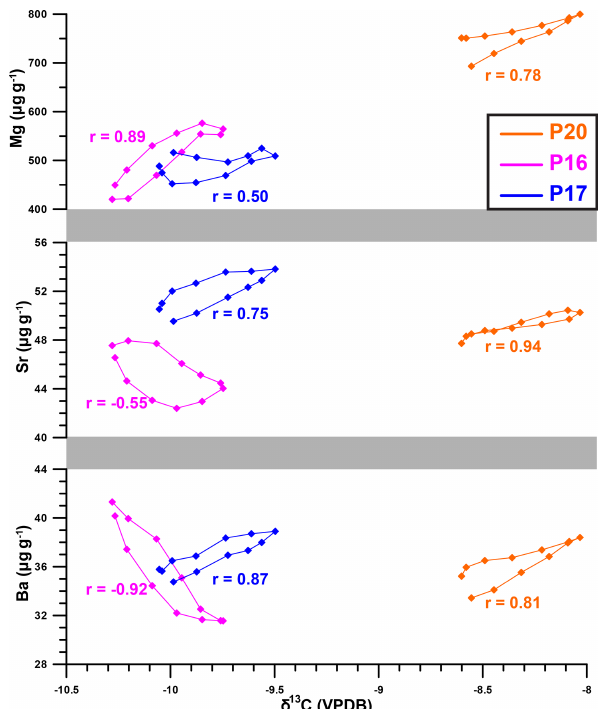
Figure 8. Cross plot showing the relationship between monthly av- erage trace-element (Mg, Sr, Ba) concentrations and δ 13 C values in the three growth periods. Plots are labelled with the Pearson’s r values indicating the strength and direction (phase relationship) of the correlation between the variables. Note the change in-phase re- lationship between δ 13 C and Sr and Ba, while δ 13 C and Mg remain positively